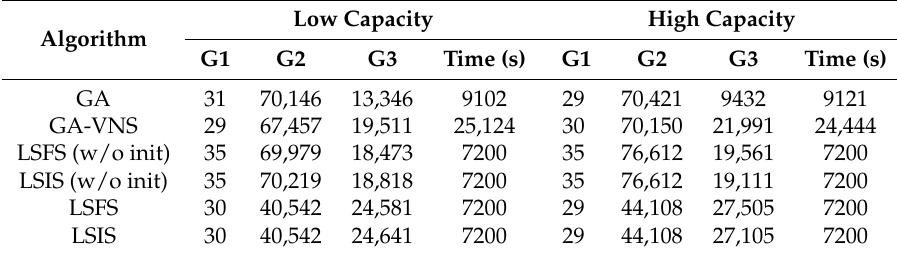
Table 4. Result of Case 4 (low capacity: 2000; high capacity: 4500).